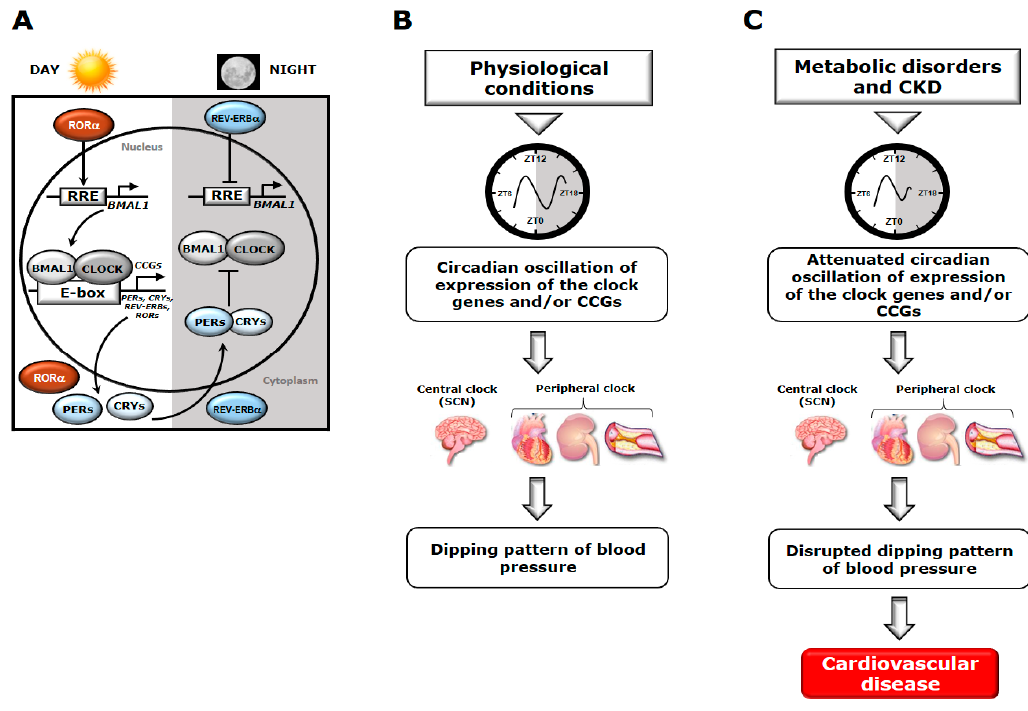
Figure 1. Schematic representation of the molecular components of the circadian timing system ( A ), and the status of circadian oscillation in the expression of clock genes and/or clock-controlled genes (CCGs) under physiological conditions ( B ) and in metabolic disorders and chronic kidney disease (CKD) ( C ). Under physiological conditions, the expression levels of the clock genes and/or CCGs undergo circadian oscillation in the central (suprachiasmatic nucleus [SCN] of the brain) and peripheral (e.g., heart, kidney, vasculature) clocks, mediated by transcriptional and translational feedback loops. The integral components of the core loop, CLOCK and BMAL1, form a heterodimer that induces E-box–mediated transcription of the negative regulators known as PERs and CRYs . Following accumulation of PER and CRY proteins, E-box–mediated transcription is repressed until cleared by proteasomal degradation. By contrast, in the regulatory or stabilizing loop, ROR α and REV-ERB α modulate the BMAL 1 mRNA levels by competitive actions on the REV-ERB/ROR–responsive element (RRE) residing in the BMAL1 promoter. All these components comprising the core and regulatory clocks determine the expression levels of core clock genes and/or CCGs via the E-box and/or RRE. Therefore, a rhythmic expression pattern is generated in physiological processes; regarding blood pressure (BP), for instance, this pattern is referred to as a dipping pattern. In subjects with metabolic dysfunction and CKD, however, loss of the circadian oscillation in the expression of core clock genes and/or CCGs leads to a disrupted dipping pattern of BP, which inevitably plays a critical role in the development of cardiovascular disorders. BMAL1: Brain and muscle arnt-like 1; CLOCK: Circadian locomotor output cycles kaput; CRYs: Cryptochromes; PERs: Periods; REV-ERVs: Nuclear receptors encoded by nuclear receptor subfamily 1, group D (NR1D); RORs: Retinoic acid receptor-related orphan receptors; RRE: REV-ERB/ROR responsive element; ZT: Zeitgeber